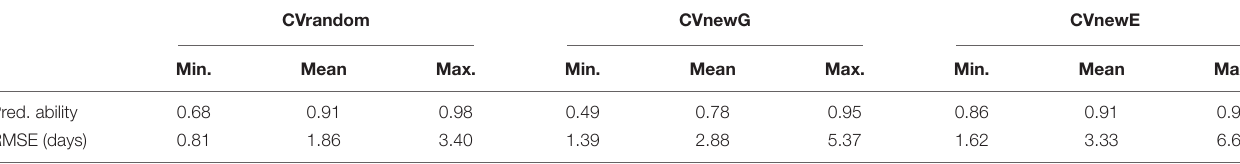
TABLE 3 | Predictive ability and RMSE of the secondary trait (HD) in the three prediction scenarios. CVrandom